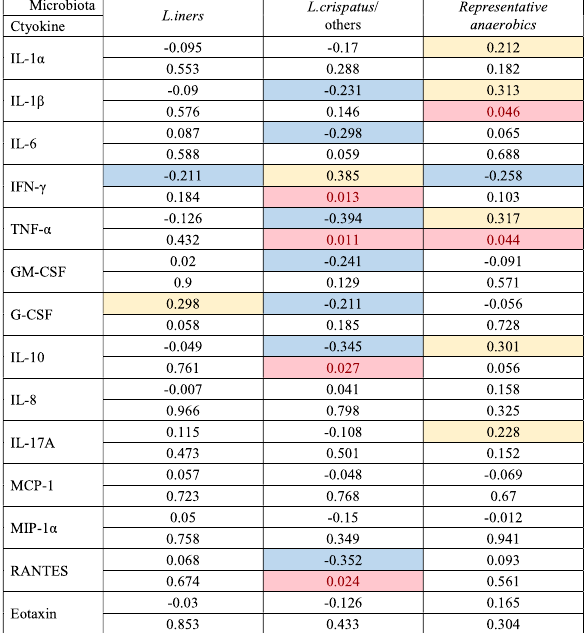
Table 4. Association between microbiota and cytokines in the first collection specimens. Upper line: correlation coefficient; lower line: significance (two-sided) p < 0.05 in red. Spearman’s rank correlation for multiple comparisons was calculated for the association of microbiota and levels of cytokines. Yellow and blue indicates positive and negative correlation, respectively. Pale yellow blocks indicate weak positive correlations (correlation coefficient 0.2–0.6). Pale blue blocks indicate weak negative correlations (correlation coefficient − 0.2 to − 0.6). Representative anaerobics: Gardnerella, Prevotella, Atopobium vaginae, Sneathia, Megasphaera and Clostridium